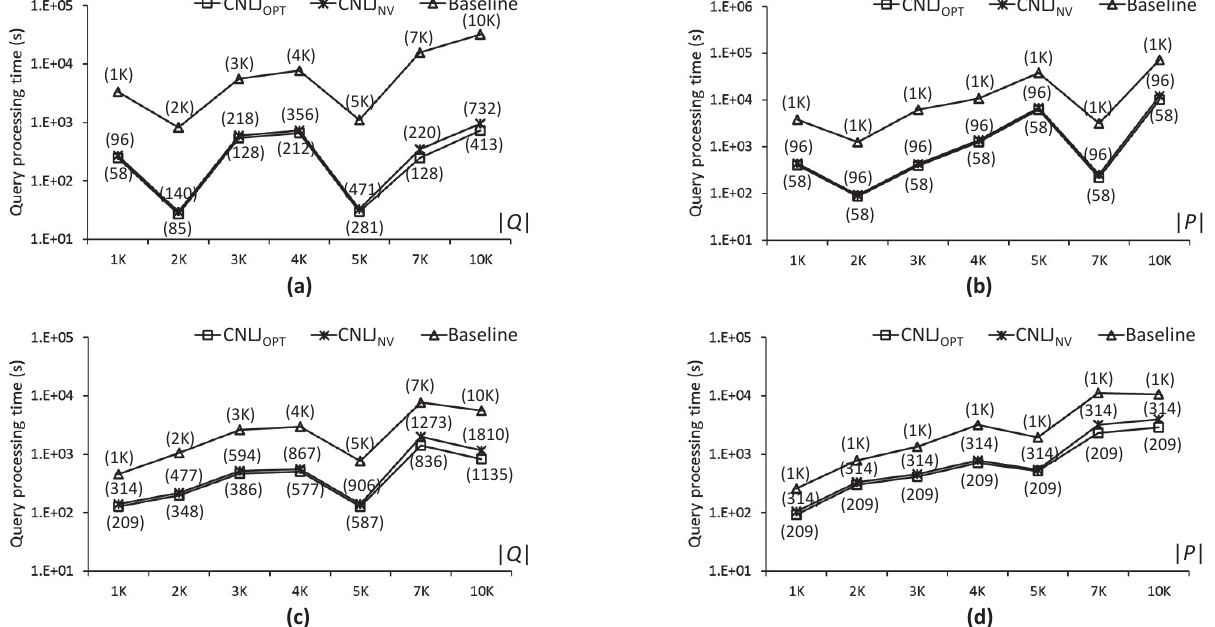
Figure 14. Scalability test: ( a ) 10 3 ≤ | Q | ≤ 10 4 for NA; ( b ) 10 3 ≤ | P | ≤ 10 4 for NA; ( c ) 10 3 ≤ | Q | ≤ 10 4 for SJ; ( d ) 10 3 ≤ | P | ≤ 10 4 for